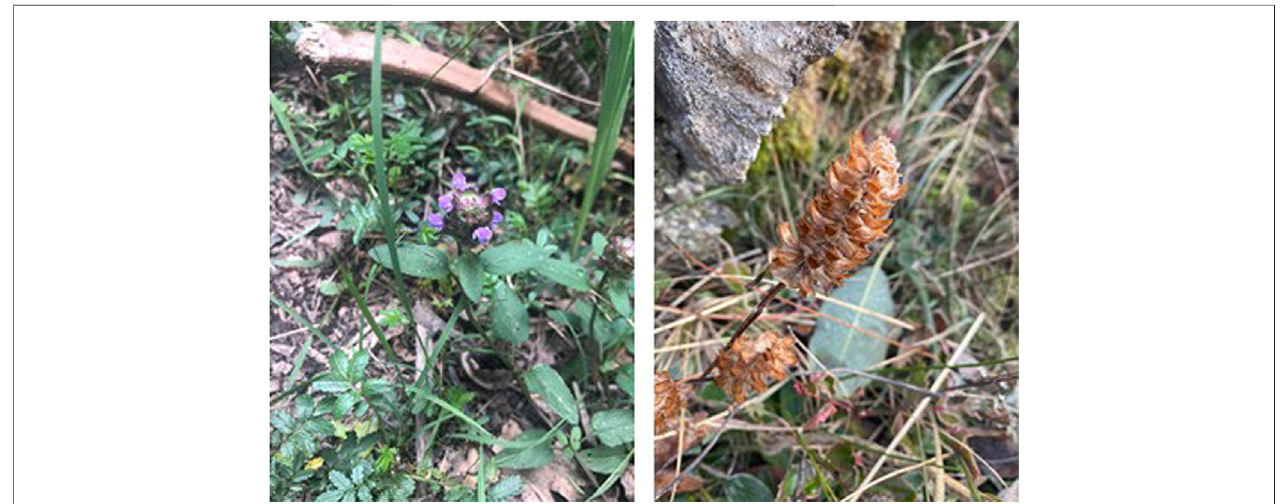
FIGURE 1 | Aerial parts and dry spikes of Prunella vulgaris L. (Global Biodiversity Information Facility).